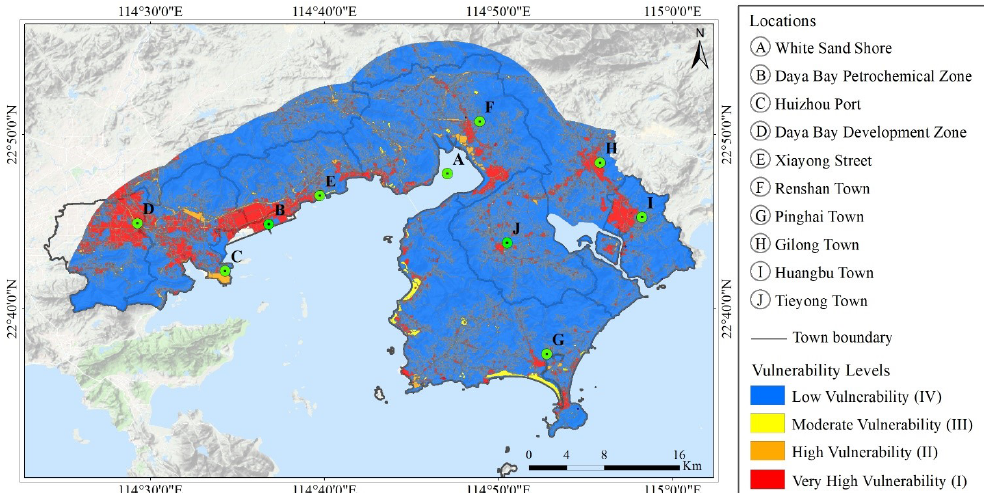
Figure 18. The map of vulnerability zones in the study area. The red means the highest vulnerability level (I), and the blue stands for the lowest vulnerability level (IV) on the map. The map was made using the ArcGIS 10.5 software based on the terrain base map layer, which was obtained from © Google Maps (map data © 2019 Google).